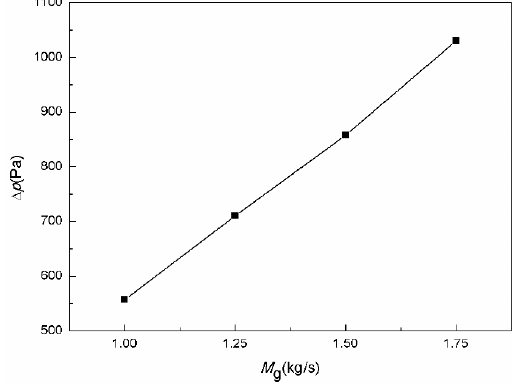
Figure 7. Influence of the air flow rate on the pressure drop.